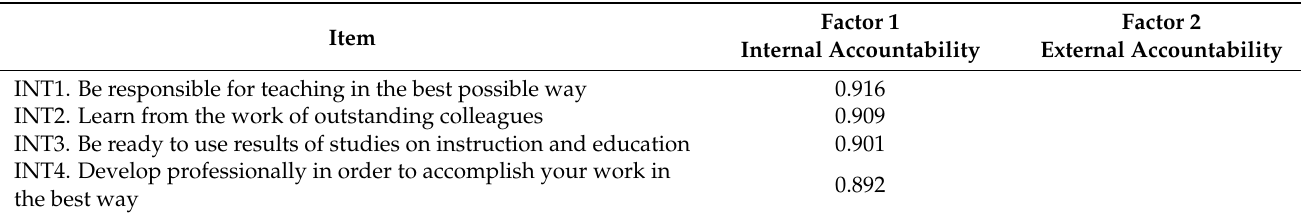
Table 2. Result of confirmatory factor analysis of teacher accountability ( n =